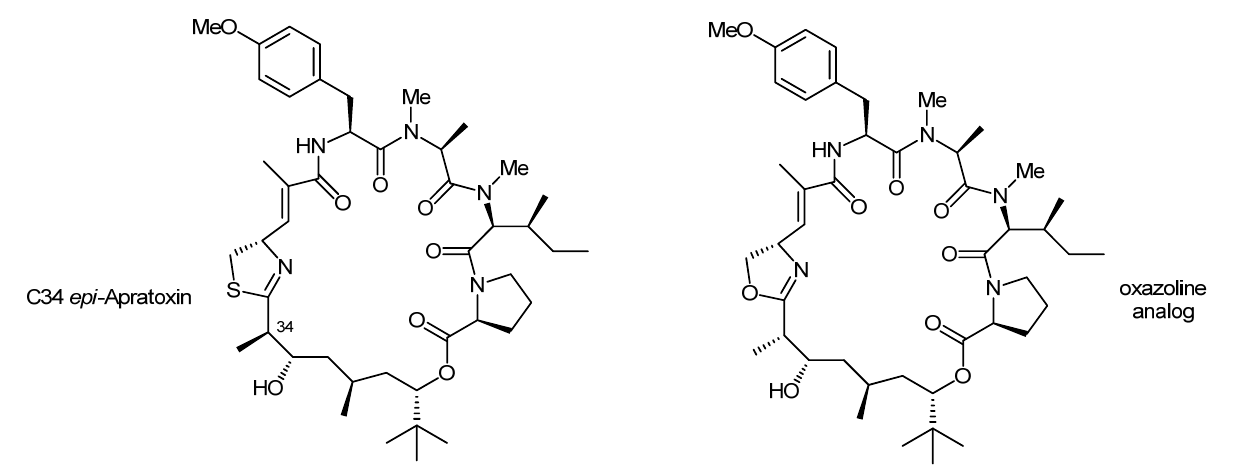
Figure 1. Apratoxin derivatives prepared by the Doi group